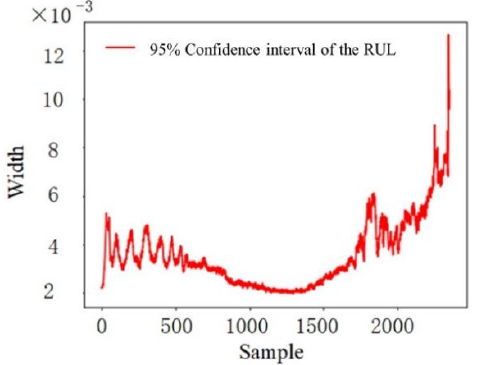
Figure 8. Distribution range of each sample point with a 95% confidence interval.